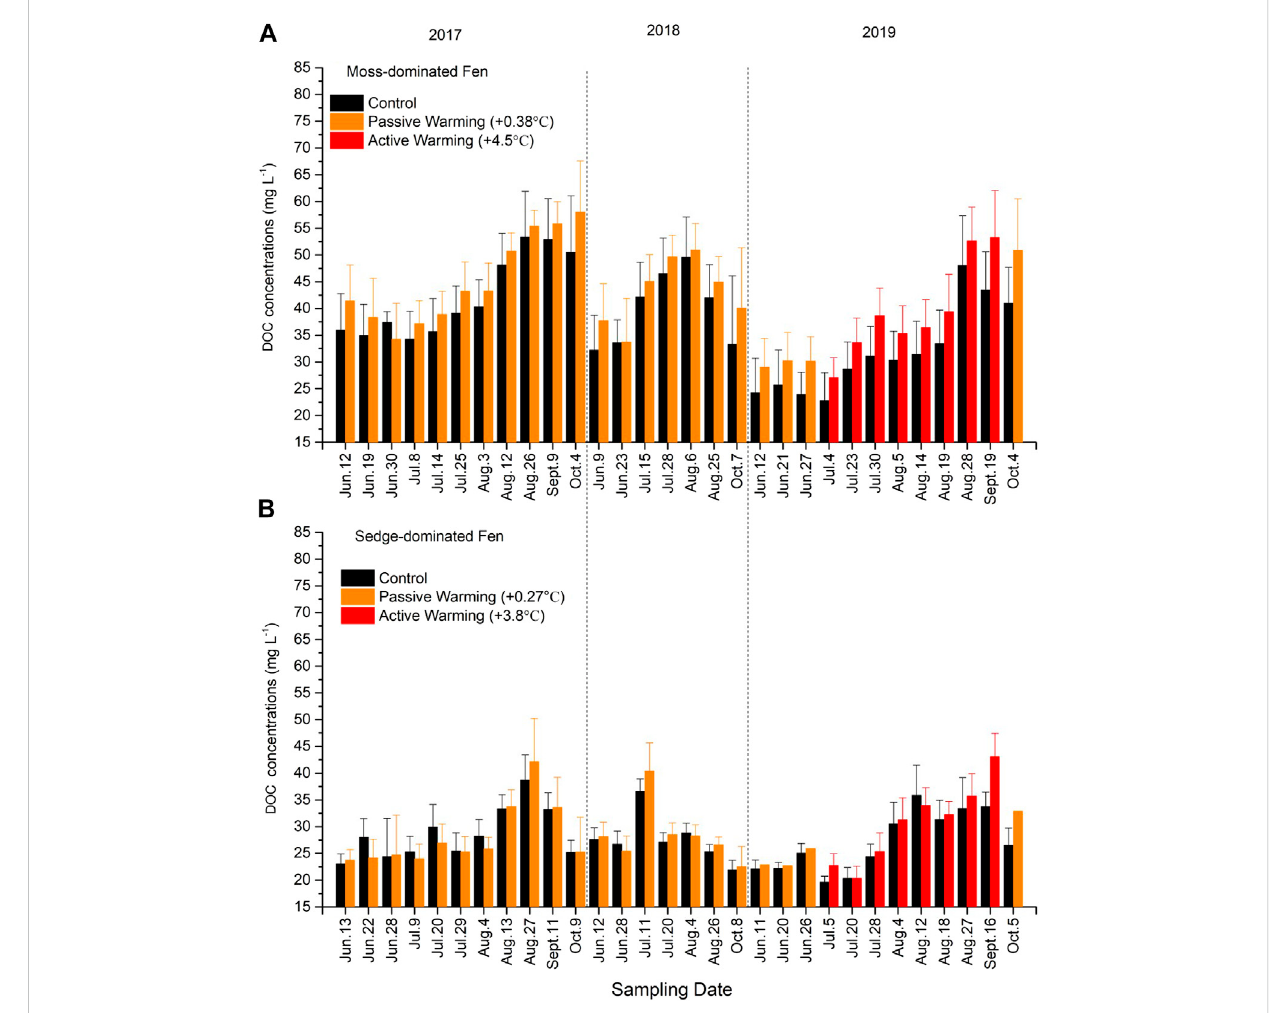
FIGURE 5 Dissolved organic carbon (DOC) concentrations in (A) the moss-dominated fen and (B) the sedge-dominated fen. Colors are different plot treatments: black for thecontrol plots; orange for thepassivelywarmed plots; red for theactivelywarmed plots. Barsare meanvaluesandwhiskers are ± one standard